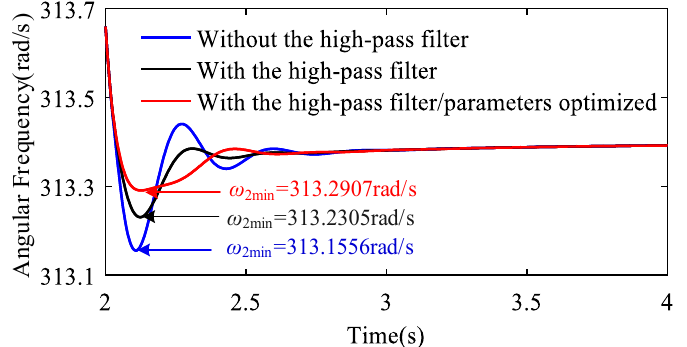
Figure 10. The simulation result of SG angular frequency in three cases under the condition of load sudden increase.